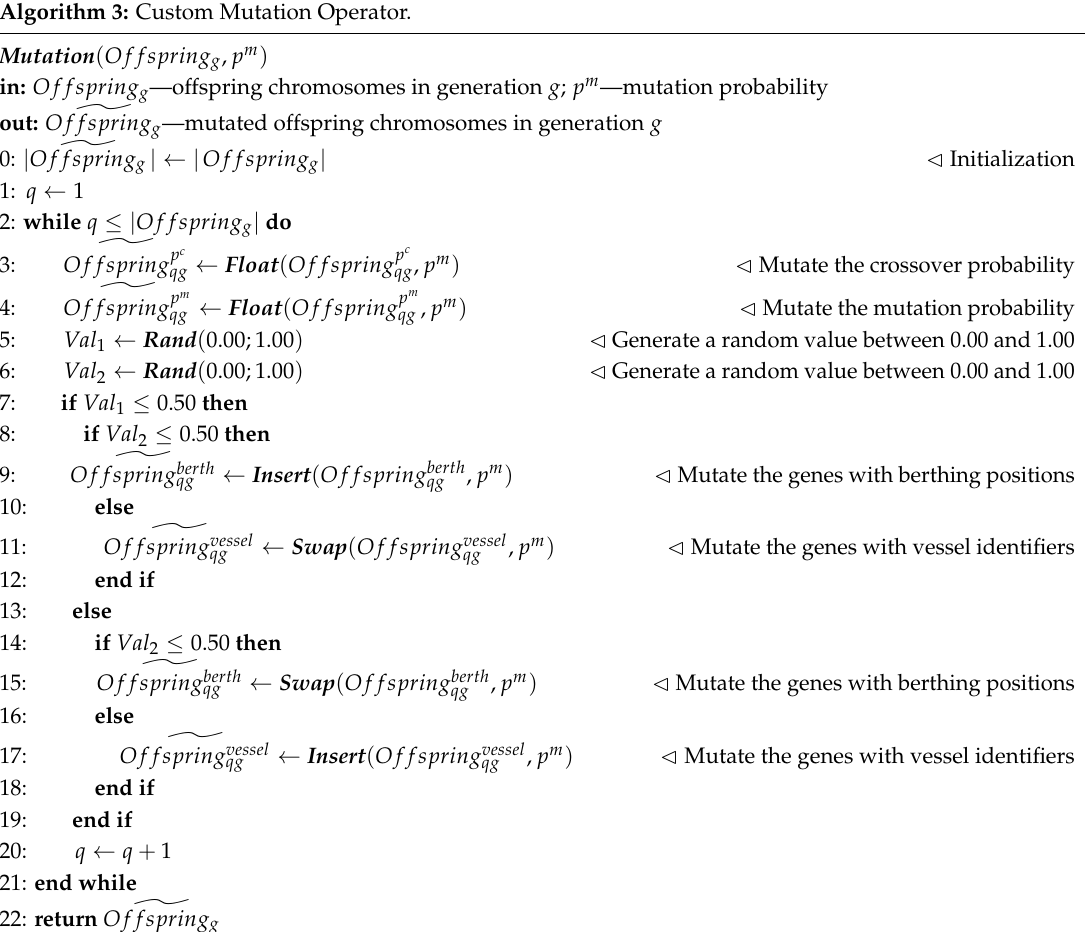
Algorithm 3: Custom Mutation Operator. Mutation ( Of fspring g , p m